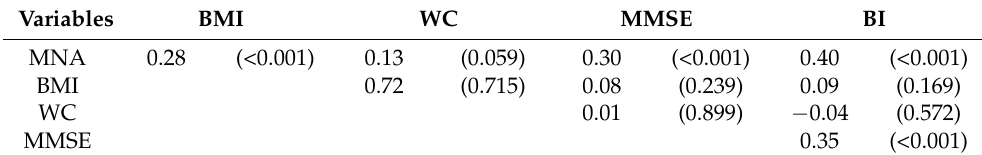
Table 5. Correlation between nutritional status, nutritional risk, and functional and mental disability. Variables BMI WC MMSE BI MNA 0.28 (<0.001) 0.13 (0.059) 0.30 (<0.001) 0.40 (<0.001) BMI 0.72 (0.715) (0.239) WC 0.01 (0.899) − 0.04 (0.572) MMSE 0.35